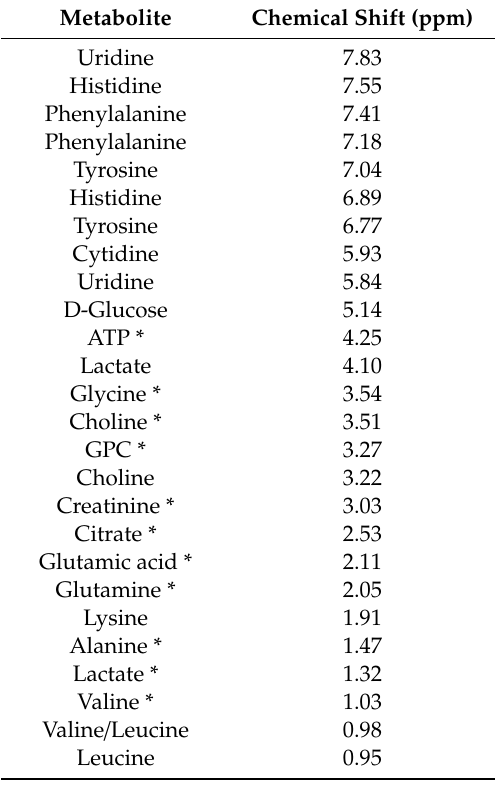
Table 1. 1 H NMR spectrum assignments of pig seminal plasma metabolites. Metabolites used in the statistical analysis are indicated by an asterisk (*).